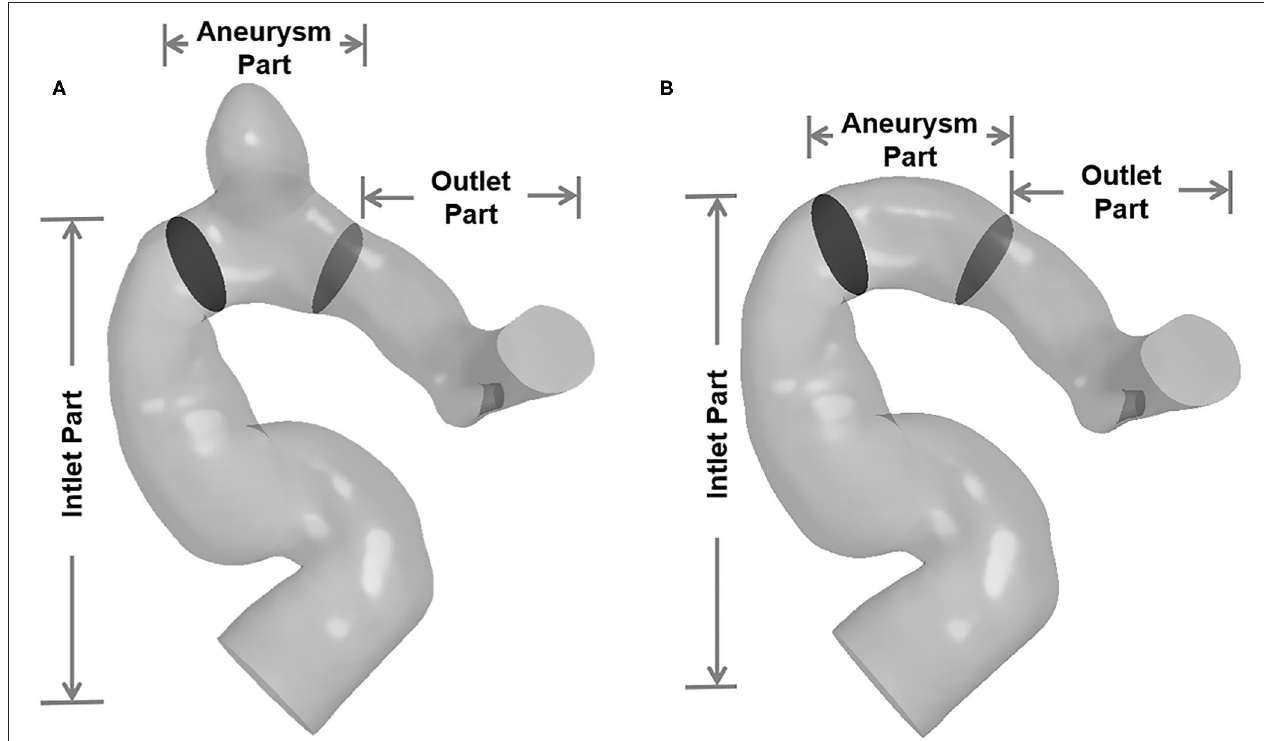
FIGURE 2 | The IA models were divided into three segments (inlet part, aneurysm part, and outlet part). (A) Three segments of with-aneurysm model. (B) Three segments of non-aneurysm